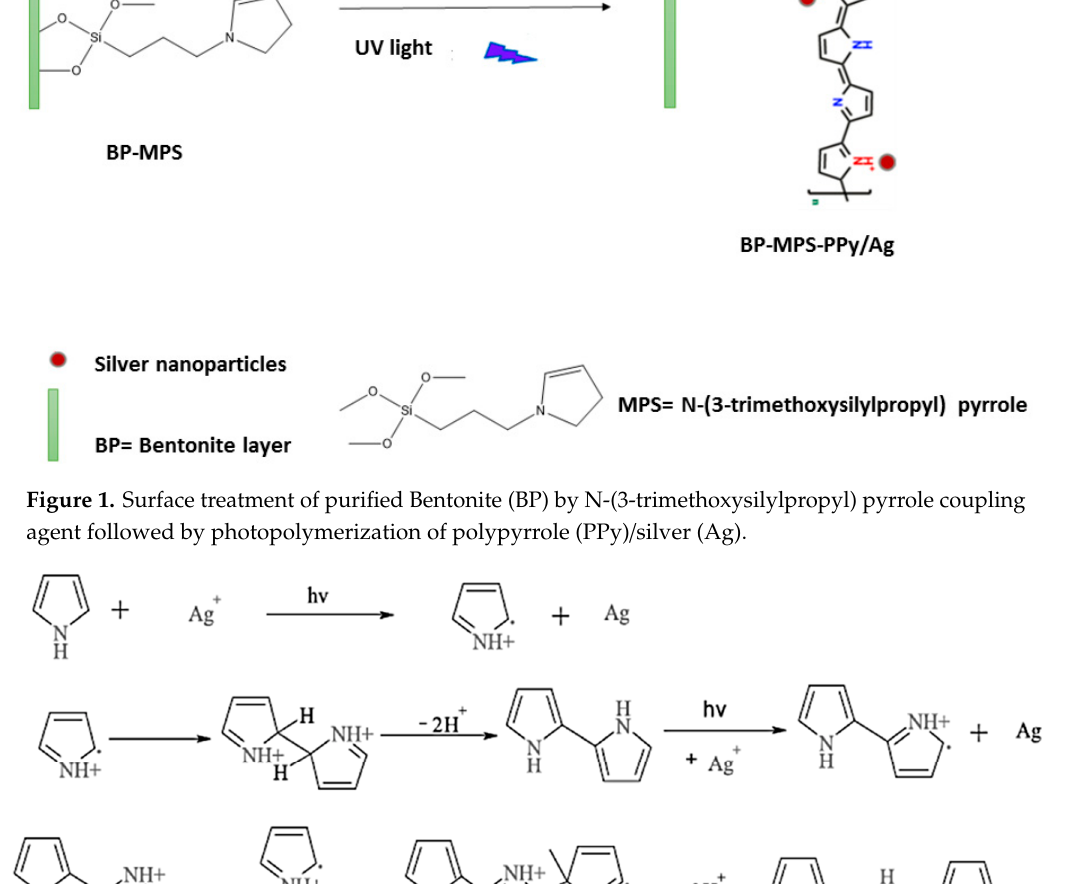
Figure 1. Surface treatment of purified Bentonite (BP) by N-(3-trimethoxysilylpropyl) pyrrole coupling agent followed by photopolymerization of polypyrrole (PPy)/silver (Ag).